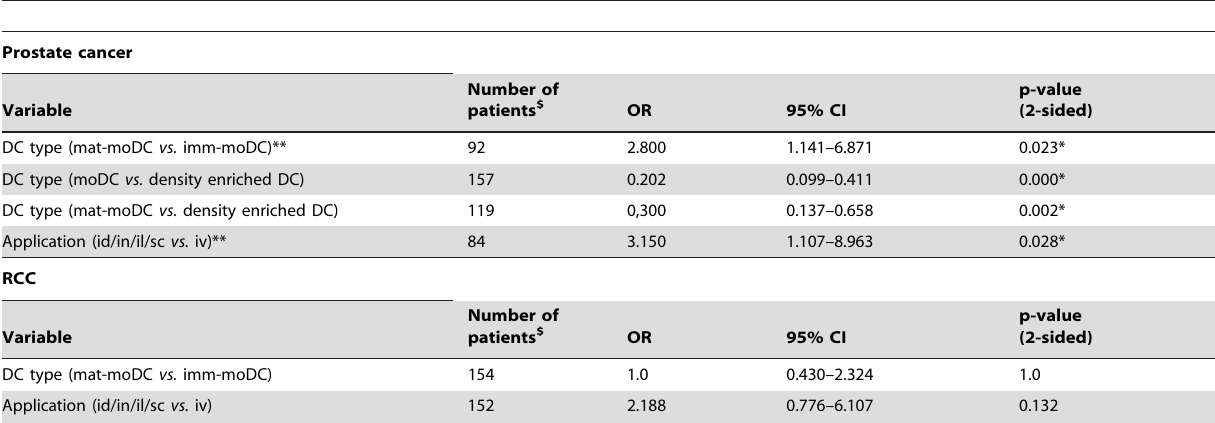
Table 3. Meta-analysis of influence on clinical benefit rate – chi-square analysis of pooled individual data across studies.